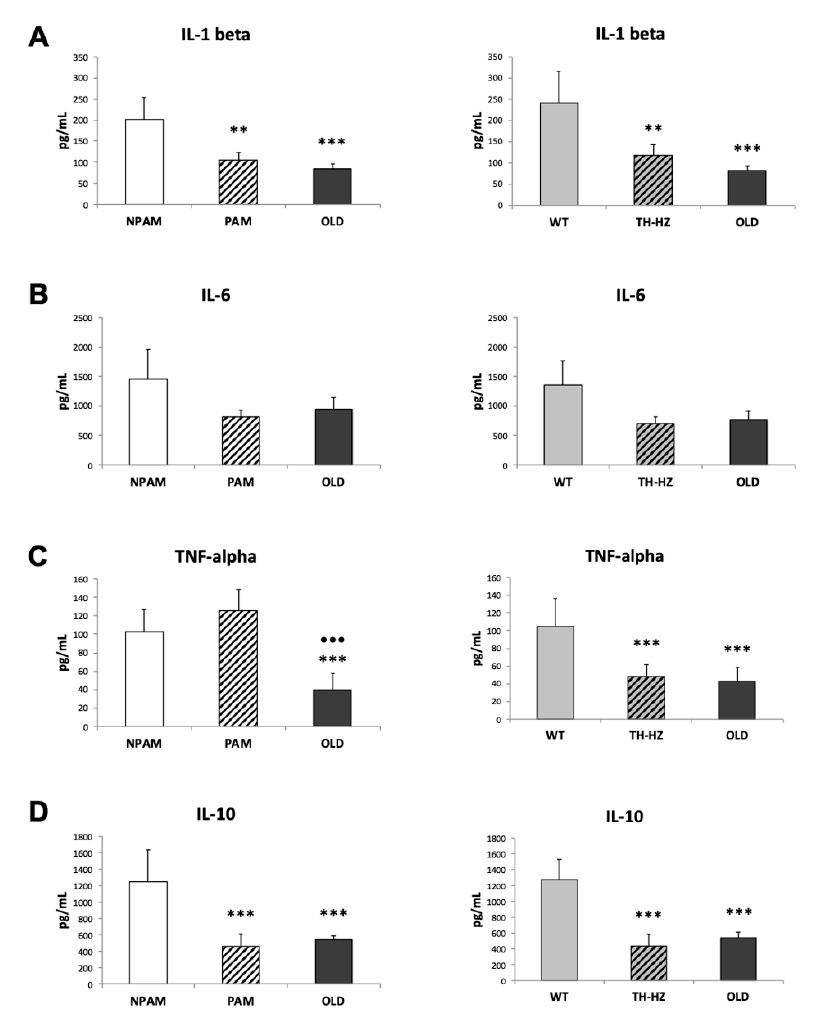
Figure 7. Pro-inflammatory and anti-inflammatory cytokines (pg/mL) released by peritoneal leukocytes incubated in presence of the mitogen LPS. IL-1 β ( A ); IL-6 ( B ); TNF- α ( C ); IL-10 ( D ) released by cells from adult PAM, NPAM, TH-HZ, WT mice, and chronologically old animals. PAM: prematurely aging mice, NPAM: non-prematurely aging mice, TH-HZ: tyrosine hydroxylase hemi-zygotic mice, WT wild-type mice. Each column is the mean ± SD of the values of 10 experiments corresponding to 10 animals. ** p < 0.01, *** p < 0.001 with respect to the corresponding controls. ··· p < 0.001 with respect to PAM.